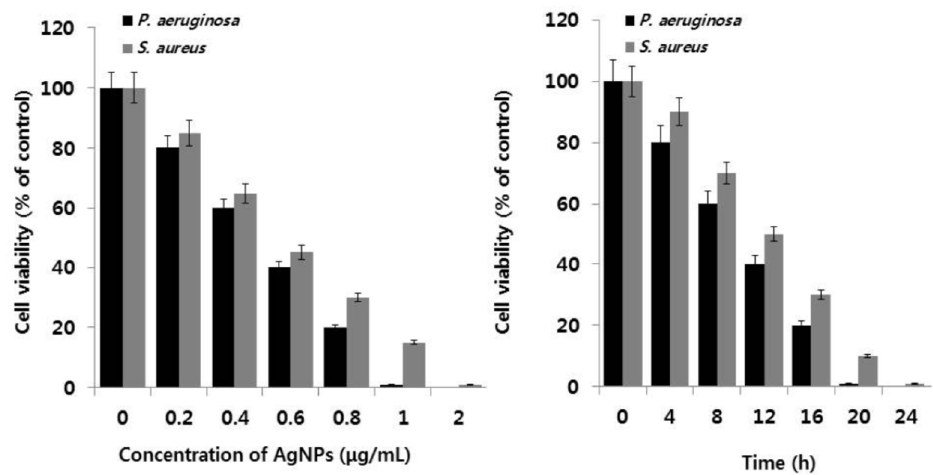
Figure 11. ( Left ): Effect of AgNPs concentration on bacterial cell viability. Bacterial survival was determined at 24 h based on a colony-forming unit (CFU) count assay. ( Right ): Time-dependent bactericidal effect of AgNPs on P. aeruginosa and S. aureus. Results were expressed as means ± SD; n = 3. p < 0.05 was considered statistically significant. Reproduced from [107], MDPI under the Creative Commons Attribution License.